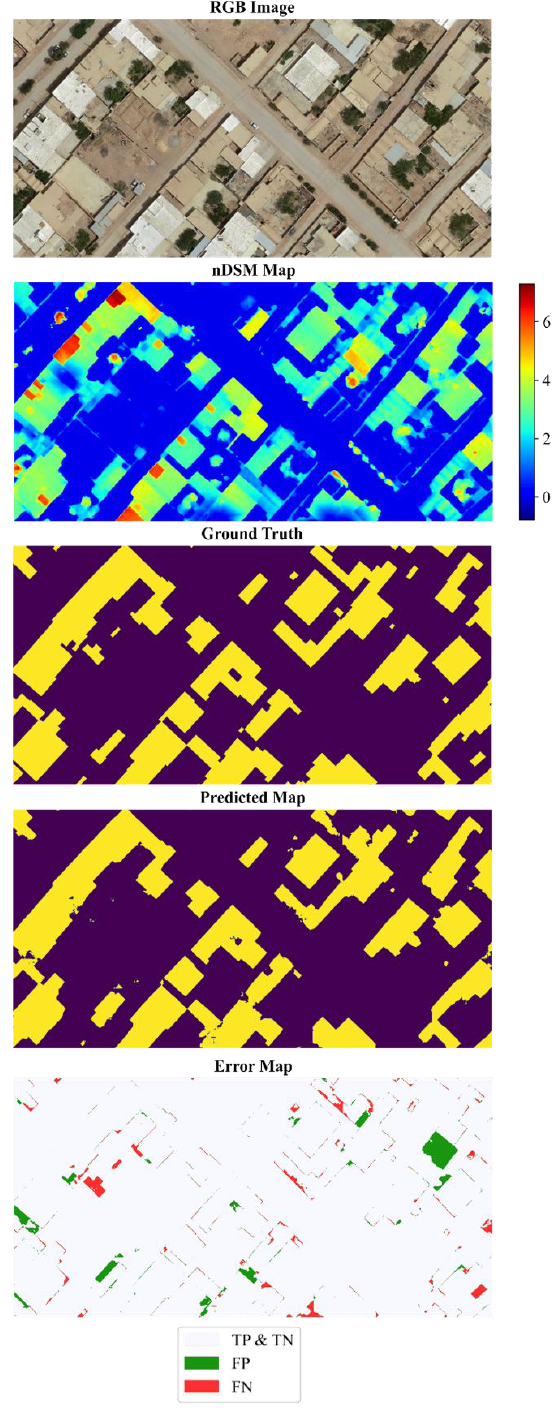
Figure 6 . The error map between the ground truth and the predicted map using the RGBD model for the sample area